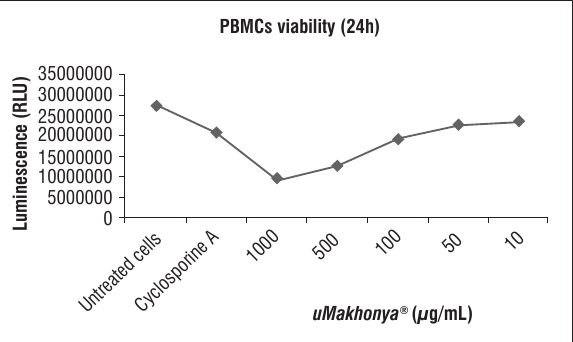
Cytotoxic effects of uMakhonya ® doses on isolated PBMCs im- mu no suppressed with 20 µg/mL of cyclosporine A. THP-1 monocytes stimulated with LPS from S. typhi and then treated with doses of uMakhonya ® showed a similar trend to PBMCs. Higher doses were significantly ( p < 0.05) cytotoxic to stimulated and unstimulated